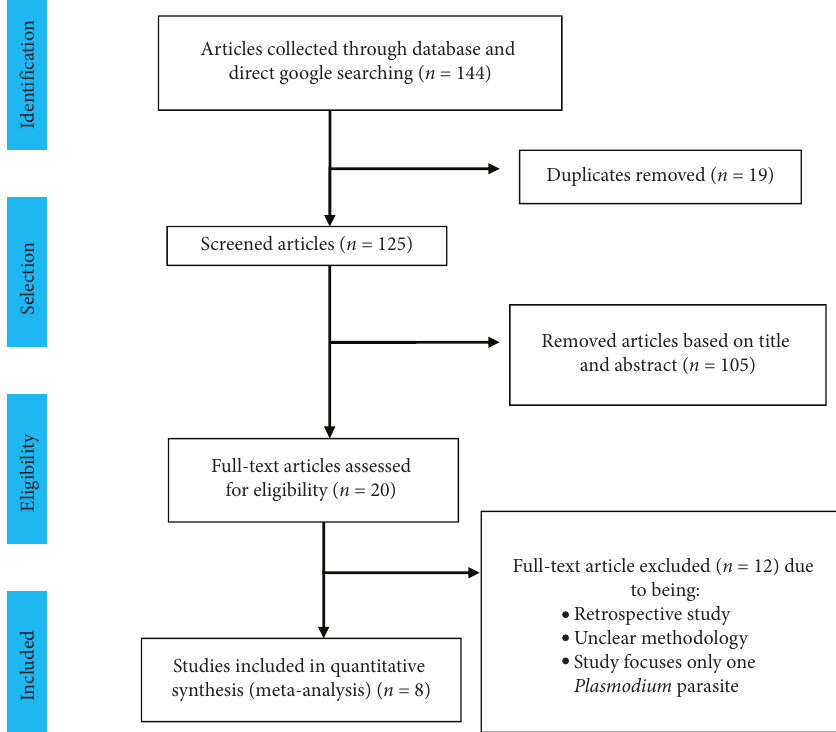
Figure 1: PRISMA flow diagram showing the selection process of eligible studies for this review,